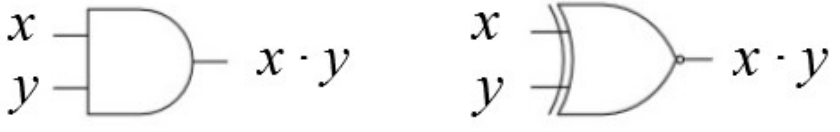
Figure 1. Basic implementation scheme of a SC multiplier in the [0,1] range (AND gate, left ) and in the [ − 1,1] range (XNOR gate, right ).